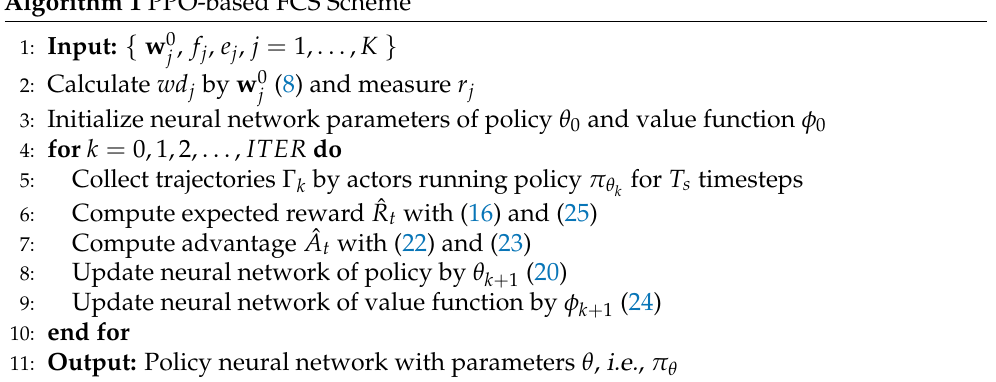
Algorithm 1 PPO-based FCS